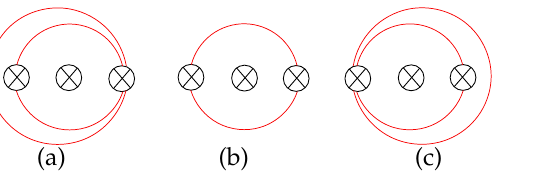
Figure 7. Almost boundary arcs on N 3,0 : (a) R 1 = 1, R 3 = 2; (b) R 1 = R 3 = 1; (c) R 1 = 2, R 3 =